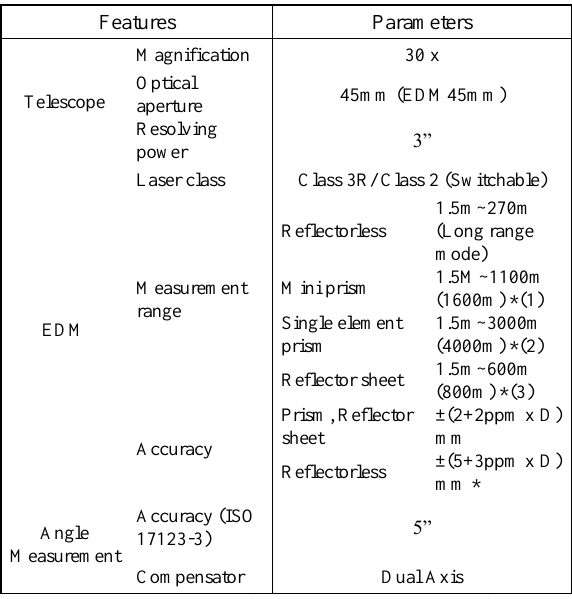
Table 3. Technical and performance characteristics of the total